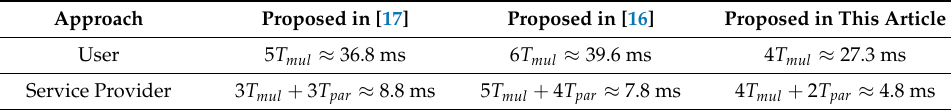
Table 5. Comparison in terms of computing